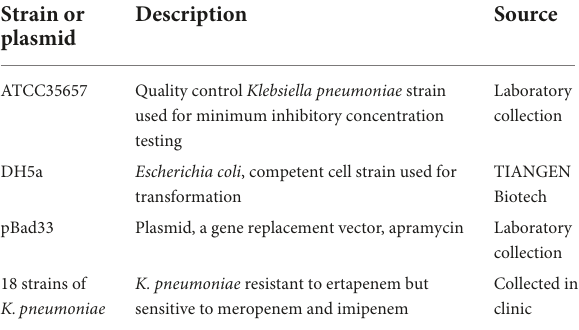
TABLE 1 Strains and plasmids used in this study. Strain or